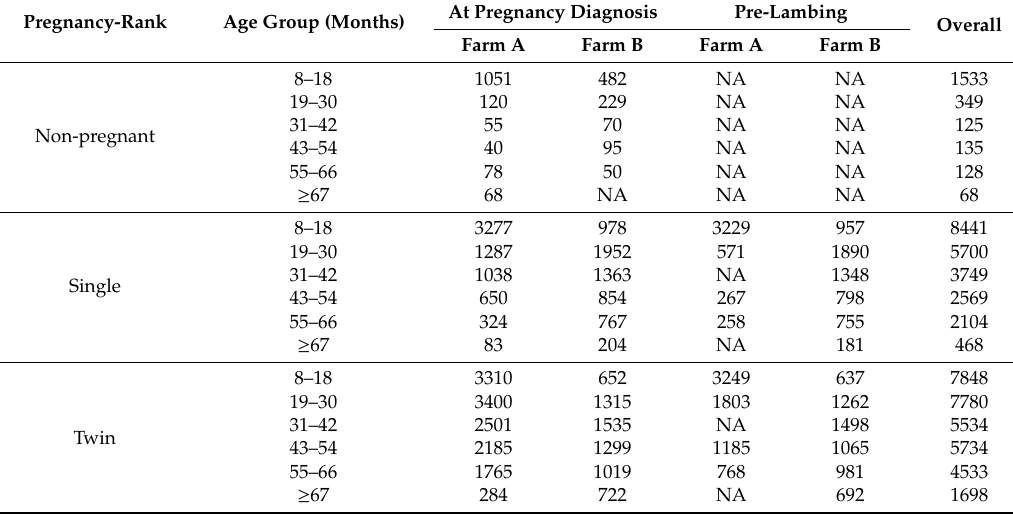
Table A2. The number of ewes by pregnancy-rank (non-pregnant, single foetus, twin), age group (8–18 months, 19–30, 31–42, 43–54, 55–66 and ≥ 67) and farm (A, B) during the di ff erent stages of the annual cycle (at pregnancy diagnosis and